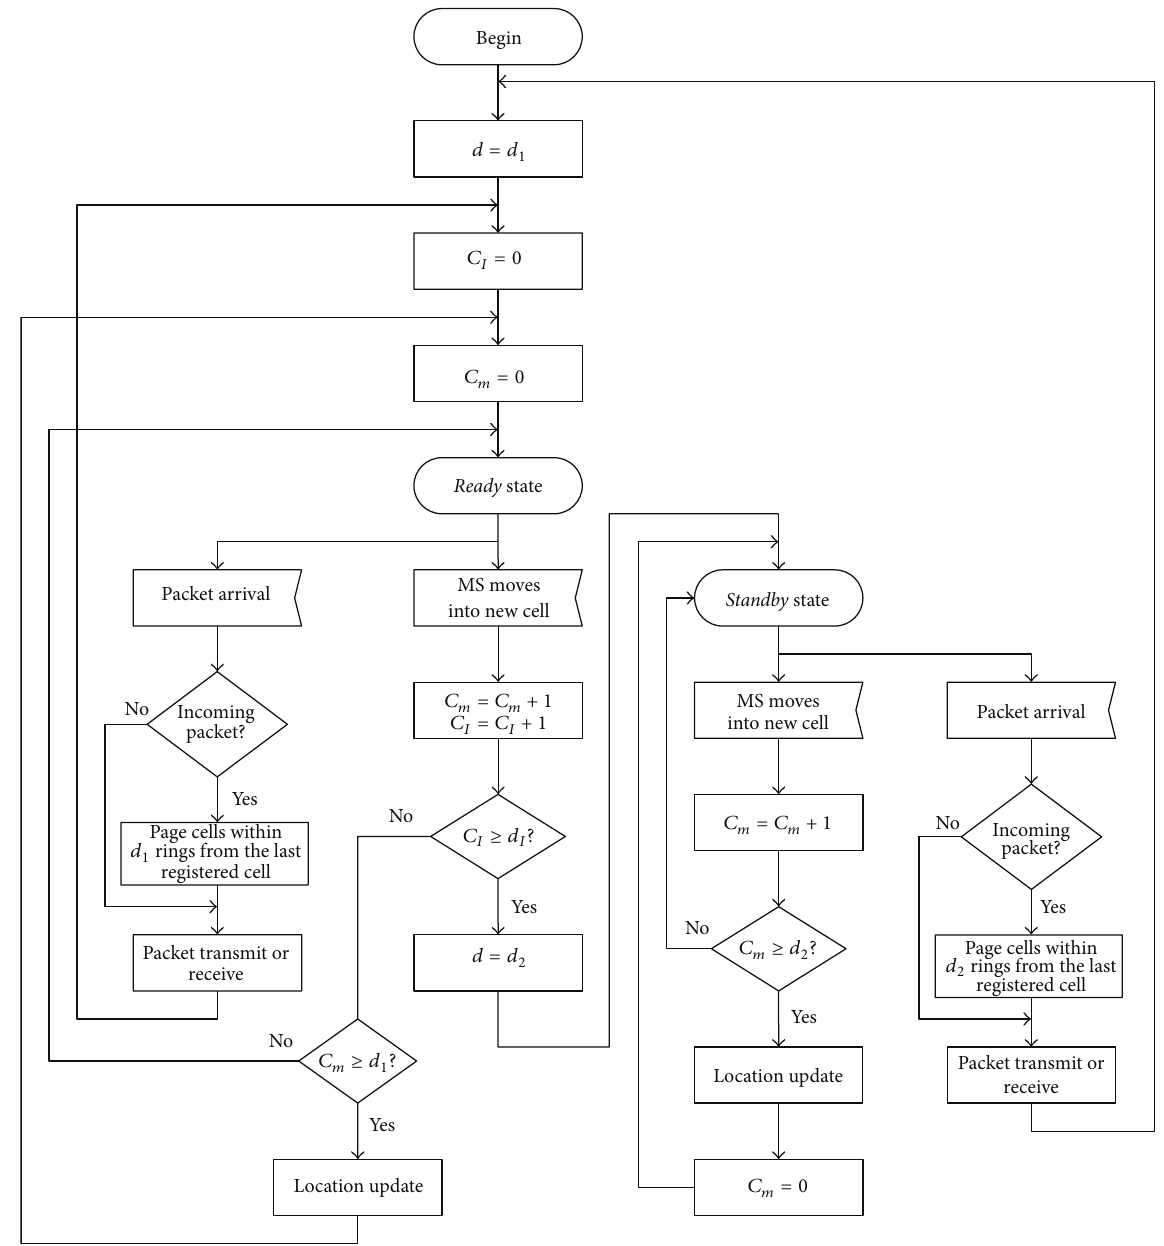
Figure 1: Flow chart for an improved movement-based location management